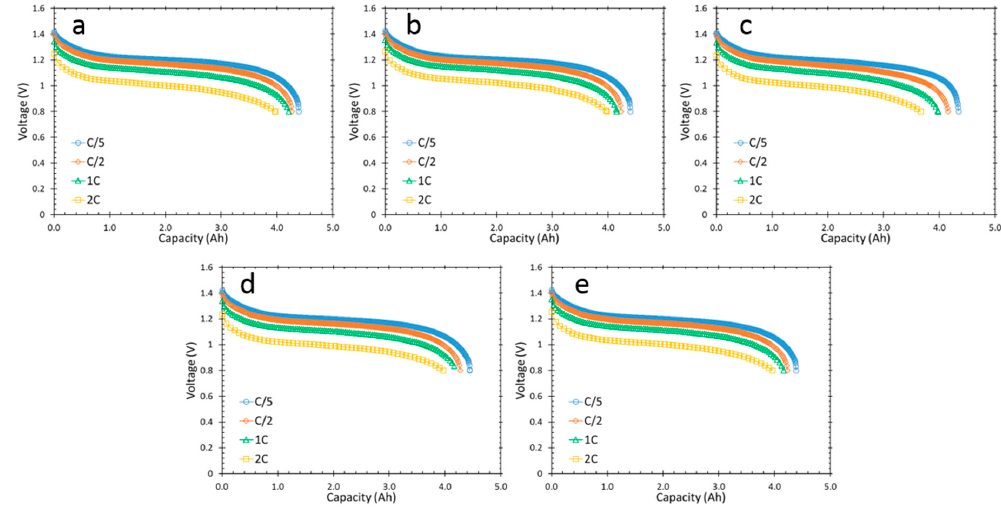
Figure 1. RT discharge voltage curves at four different rates (C/5, C/2, 1C and 2C) for cells ( a ) Fe1, ( b ) Fe2, ( c ) Fe3, ( d ) Fe4 and ( e ) Fe5.